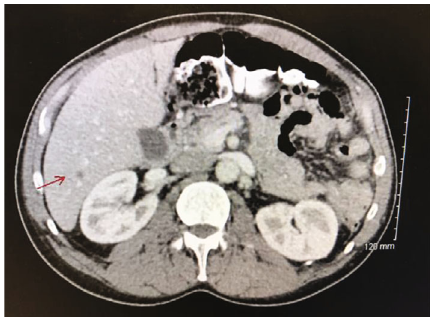
Figure 5: CT with contrast imaging of liver metastasis